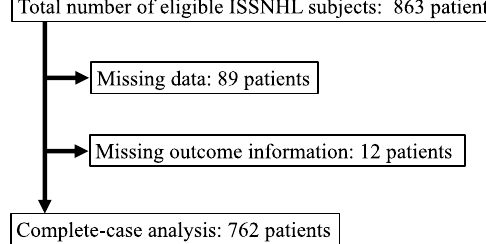
Figure 2. Flow diagram for study inclusion. ISSNHL, idiopathic sudden sensorineural hearing